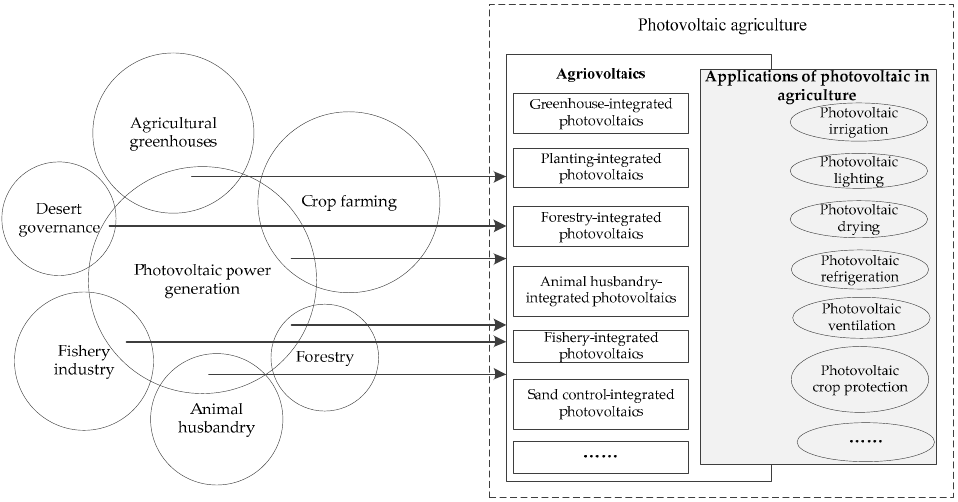
Figure 2. Composition of photovoltaic